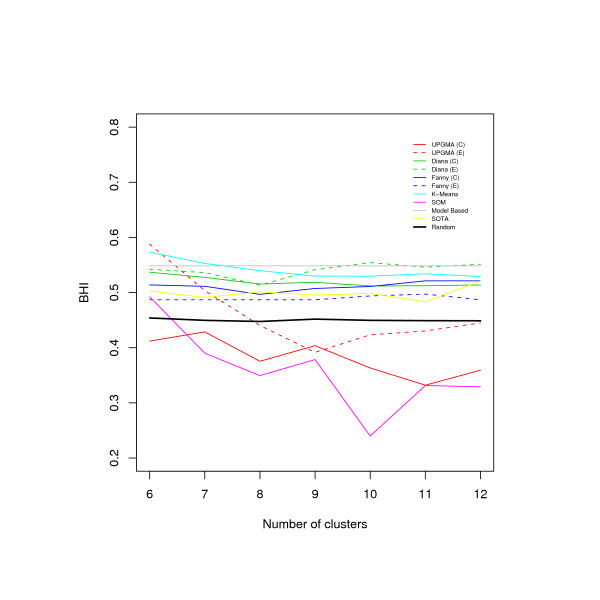
BHI for various clustering algorithms applied to the positively expressed genes in yeast sporulation data with functional classes from FunCat. The thick black line is the 95th percentile of BHI values under random clustering.